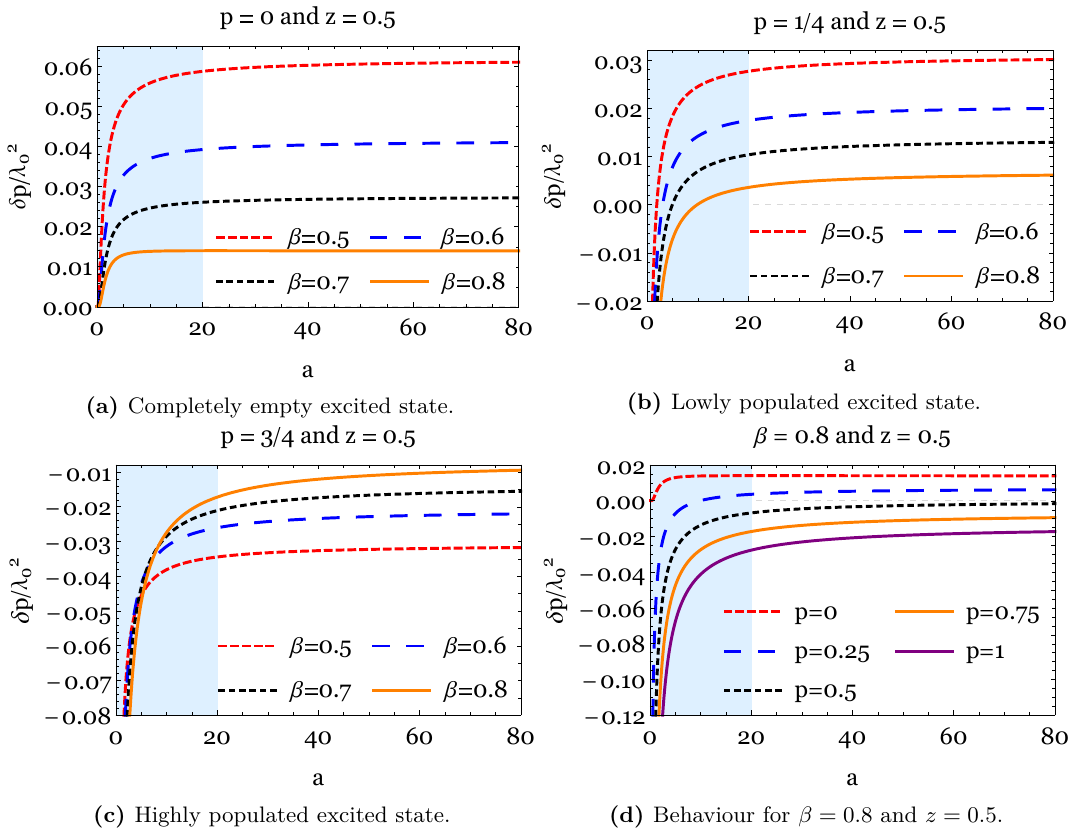
Figure 6. Behaviour of the transition probability with respect to reduced acceleration a in the near boundary regime for various values of p and β